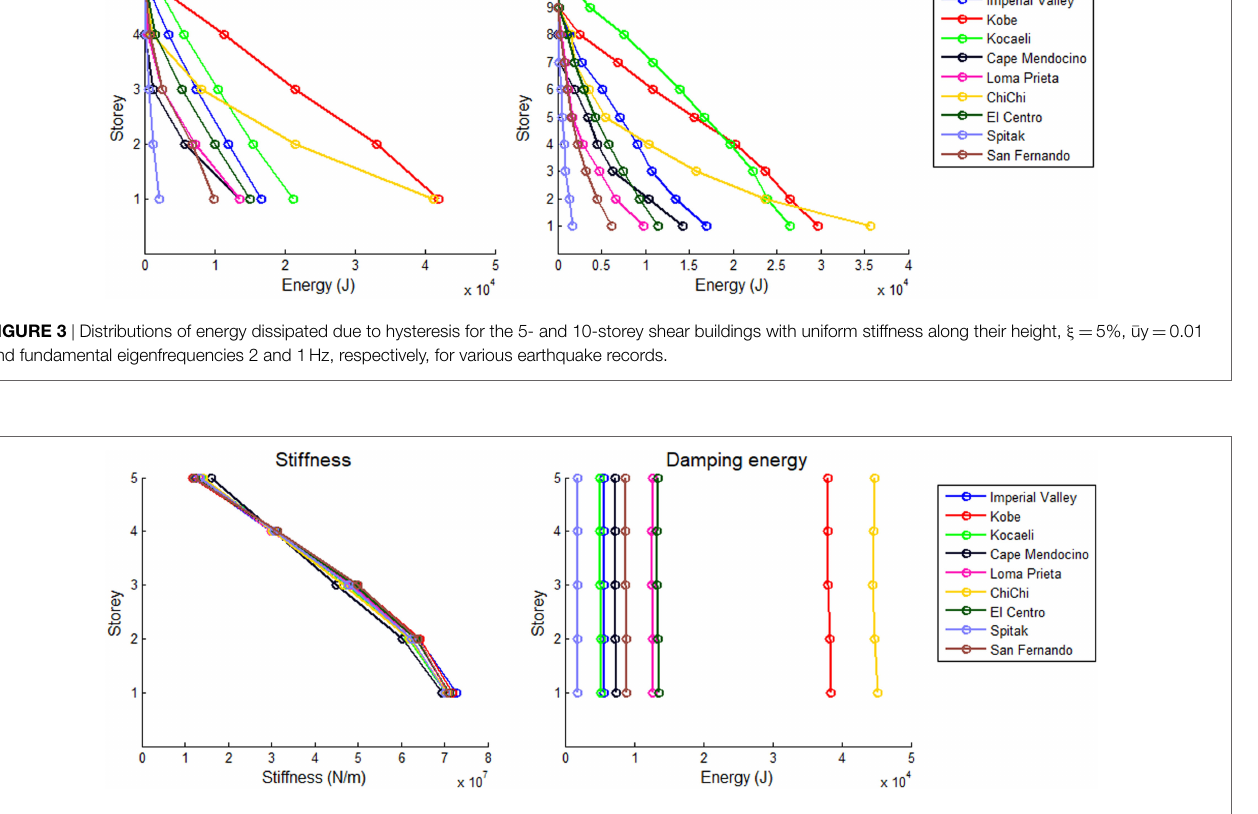
FIGURE 4 | Optimum distributions of elastic stiffness and energy dissipated due to damping for the 5-storey shear building with ξ = 5% for various earthquake records.